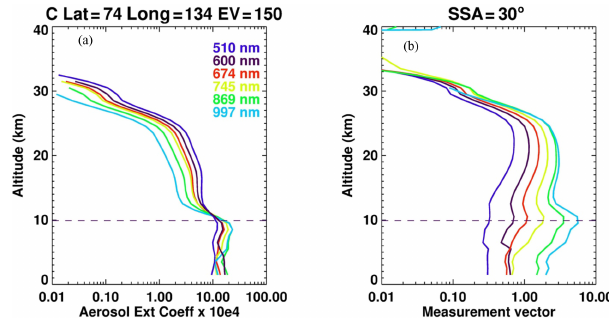
Figure 2. Same as Fig. 1 but for event 150 in the